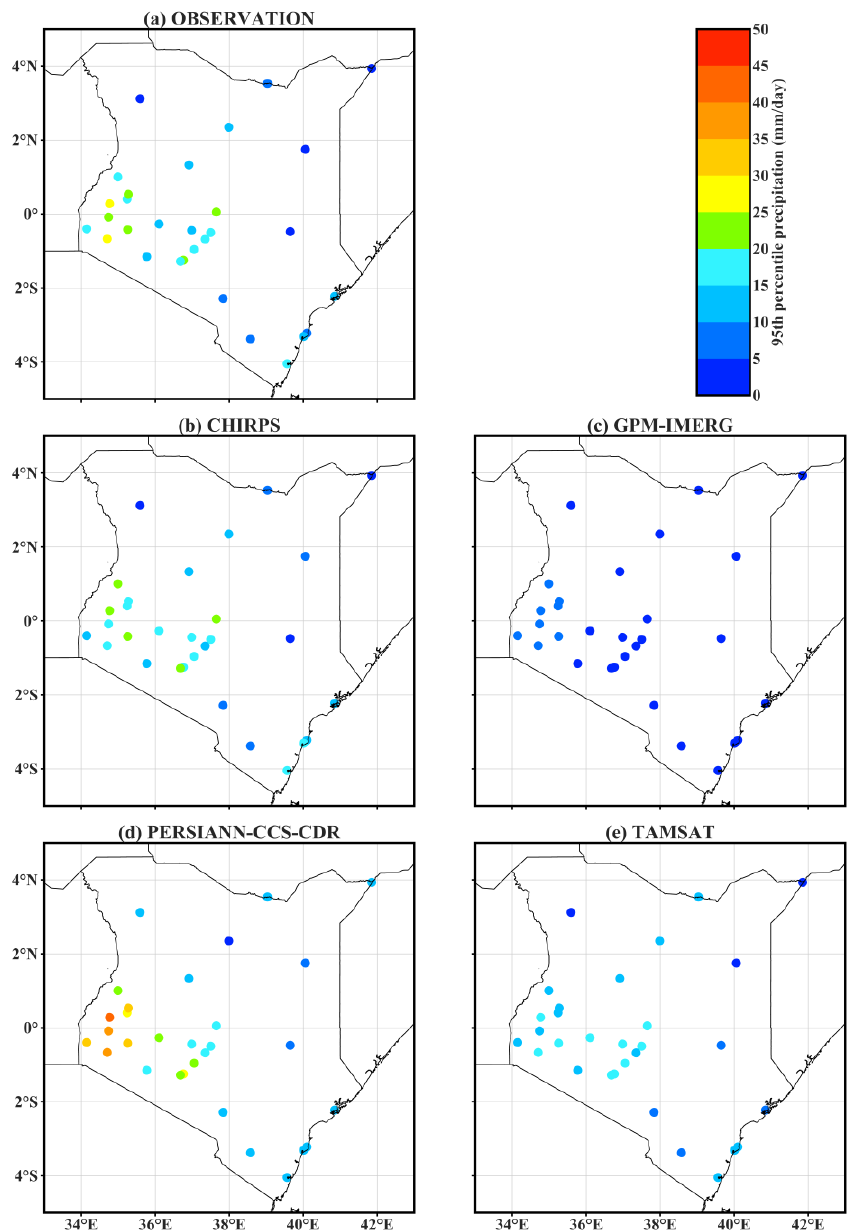
Figure 2. Observation and satellite estimate of 95th percentile PRE quantities over Kenya: ( a ) OBSERVATION, ( b ) CHIRPS, ( c ) GPM-IMERG, ( d ) PERSIANN-CCS-CDR, and ( e ) TAMSAT.